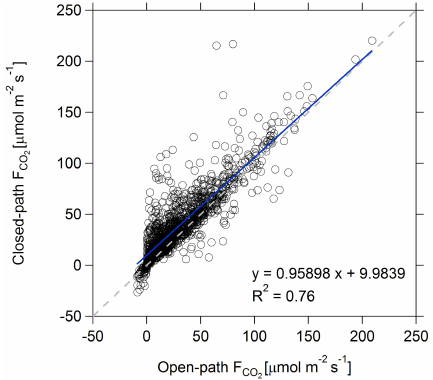
Figure 2. Comparison of half-hourly fluxes of CO 2 measured in March, August and October 2013 by a closed-path Picarro G1301-f operating at 1Hz following high-frequency loss correction and an open-path Li7500 analyser operating at 20Hz at the top of BT tower (sensor height: 190ma.g.l.). Dashed line is 1:1